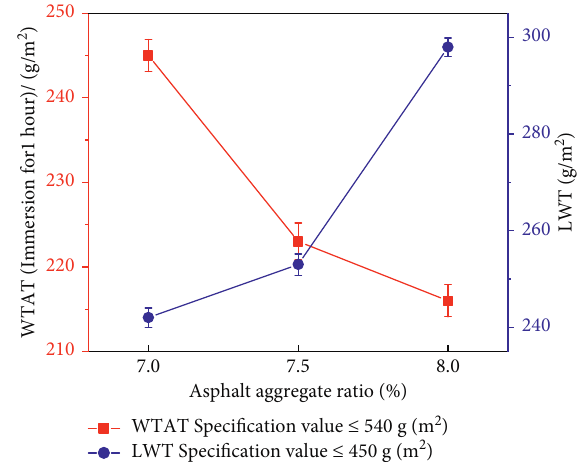
Figure 4: WTATand LWTunder different asphalt aggregate